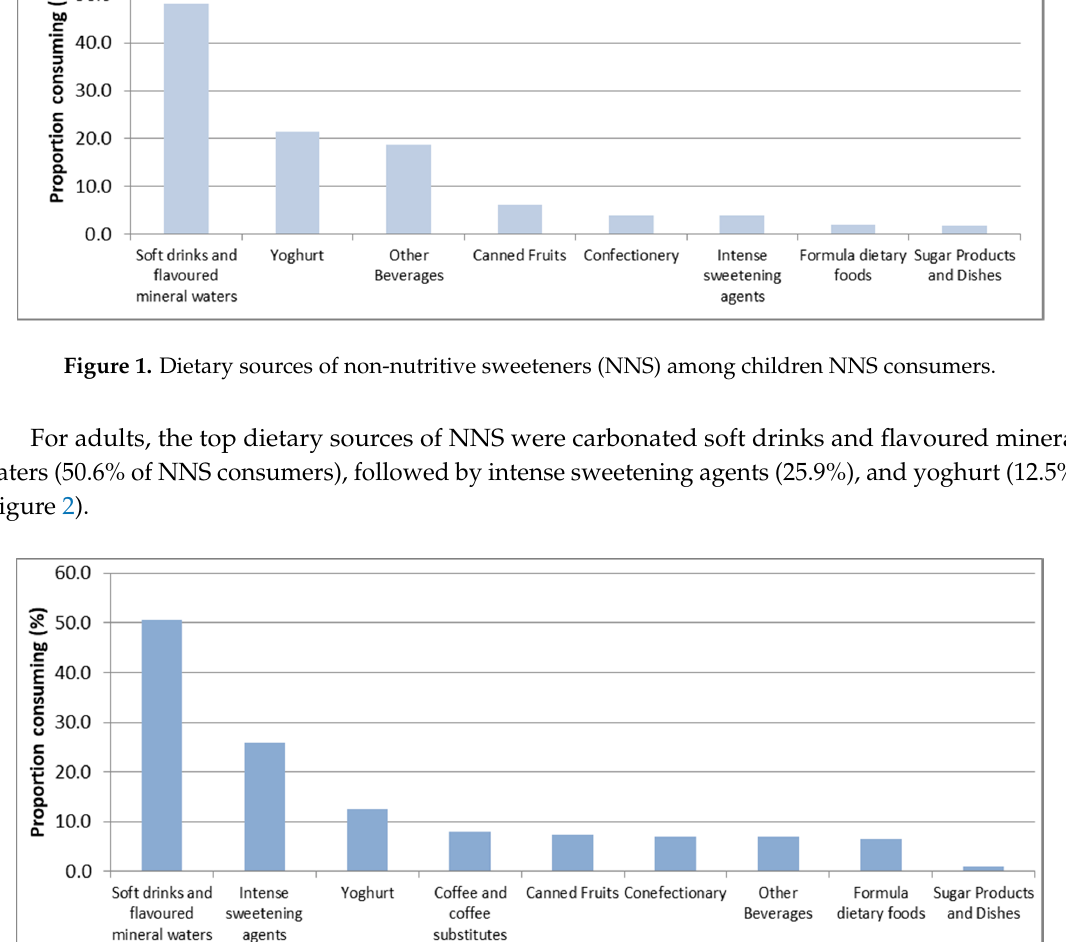
Figure 2. Dietary sources of NNS among adult NNS consumers.